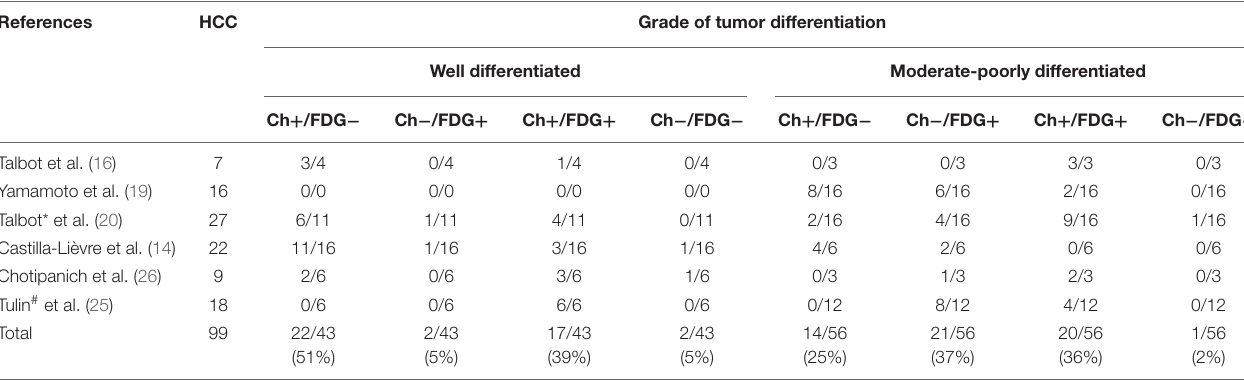
TABLE 2 | Dual PET radiotracer behaviors function of HCC level of